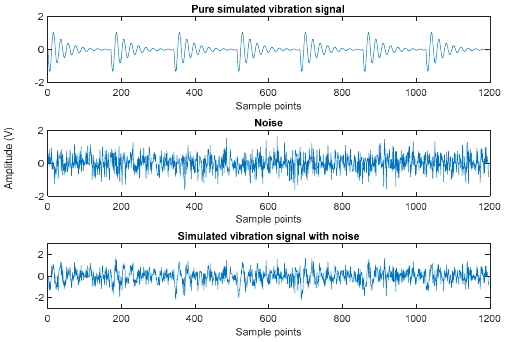
Figure 11. Simulated vibration signal.